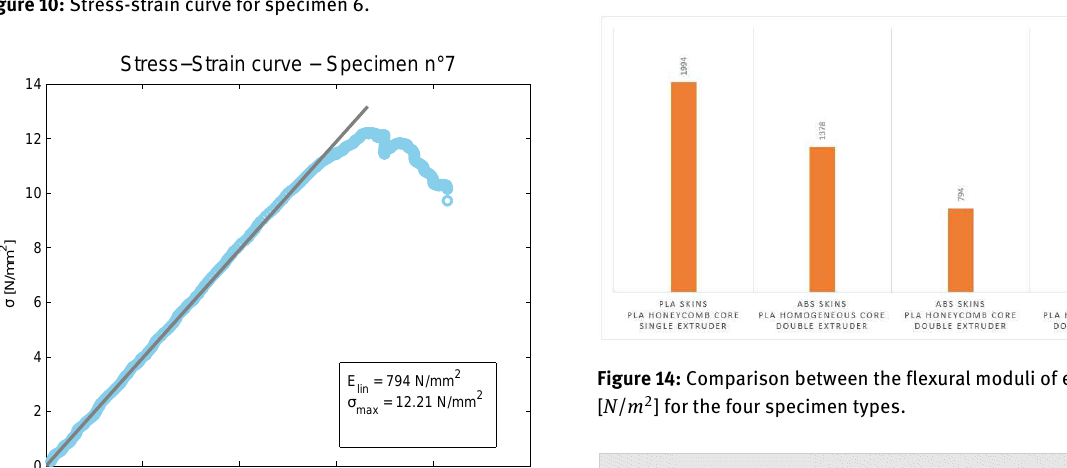
Figure 13: Probability plot of the flexural modulus of elasticity [ N / m 2 ] for specimens 1-5.